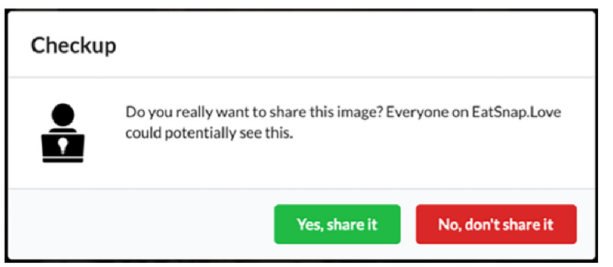
Fig 4. The nudge implemented in EatSnap.Love. In the privacy nudge condition, participants were confronted with this additional checkup window after they clicked ‘submit’ to post a photo. In the no privacy nudge condition, the post was directly published after participants clicked